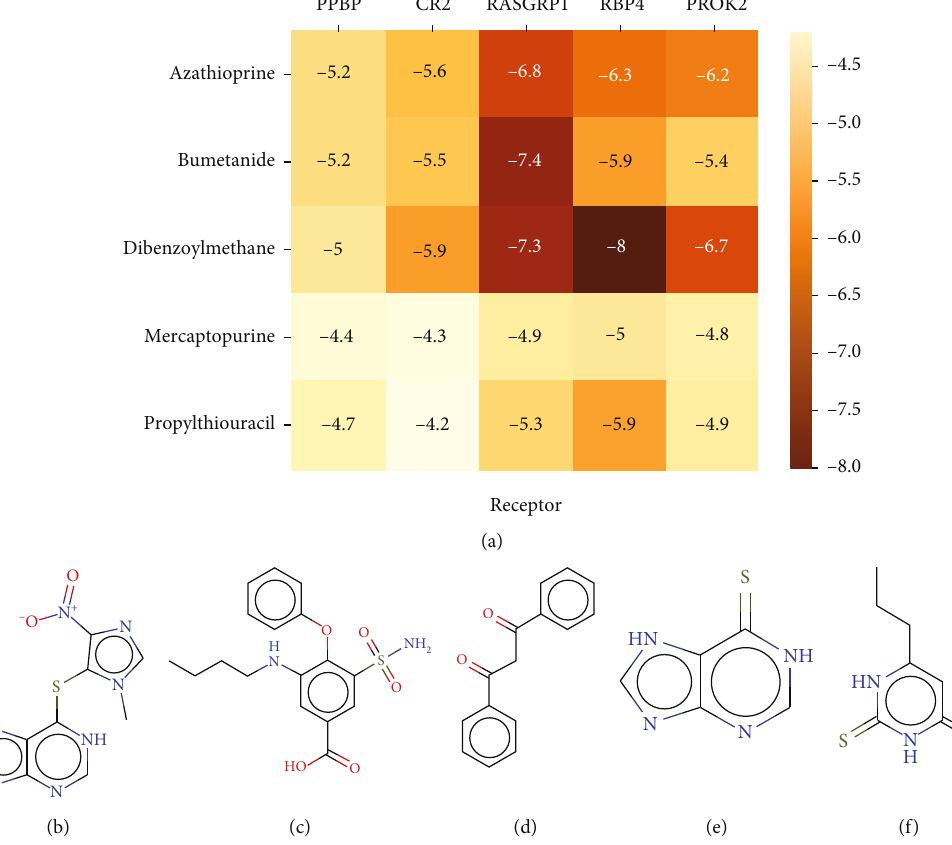
Figure 8: Identi fi cation and validation of small-molecule drugs. (a) The heatmap performs the lowest binding energy for molecular docking. (b – f) Chemical structure depiction of the potential small-molecule drugs. (b) Azathioprine, (c) bumetanide (d) dibenzoylmethane, (e) mercaptopurine, and (f)